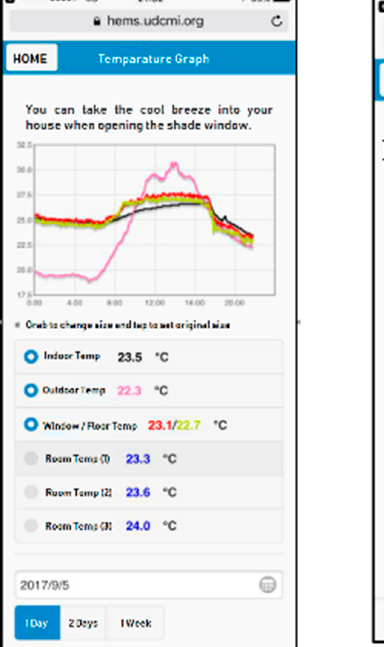
Figure 6. Screenshots of the smartphone application: ( a ) Room environment information ( b ) electricity usage information.